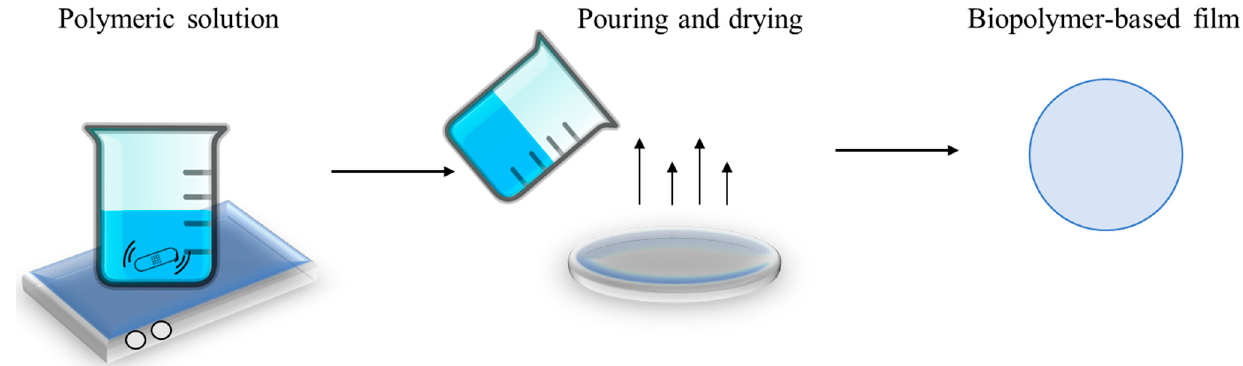
Figure 1. Solvent casting method scheme.